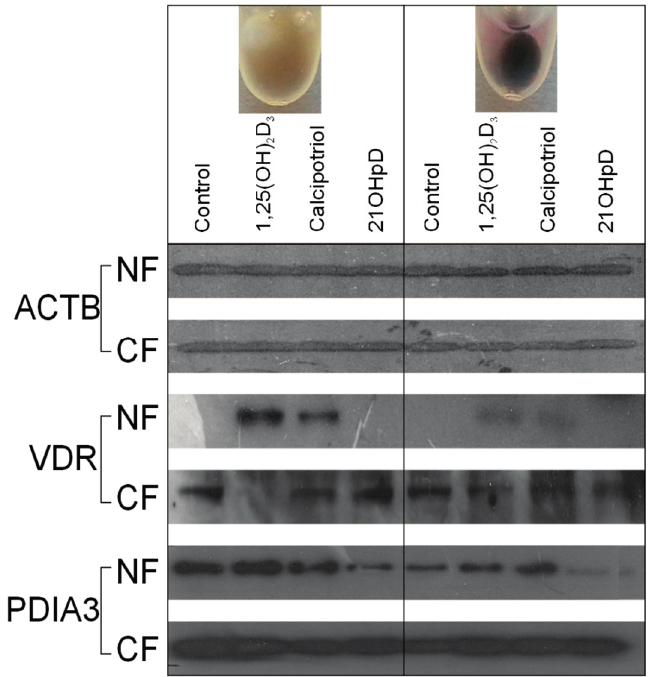
Figure 8. Western blot analysis of the effects of 1,25(OH) 2 D 3 , calcipotriol and 21(OH)pD on the cytoplasmic and nuclear location of the VDR and the PDIA3 receptor. Pigmented and non-pigmented B16-F10 melanoma cells were treated with 10 nM 1,25(OH) 2 D 3 , calcipotriol or 21(OH)pD, and VDR and PDIA3 receptors in cytoplasmic (CF) and nuclear fractions (NF) measured by western blotting, as described in the Materials and Methods section. Actin (ACTB) was used as a loading